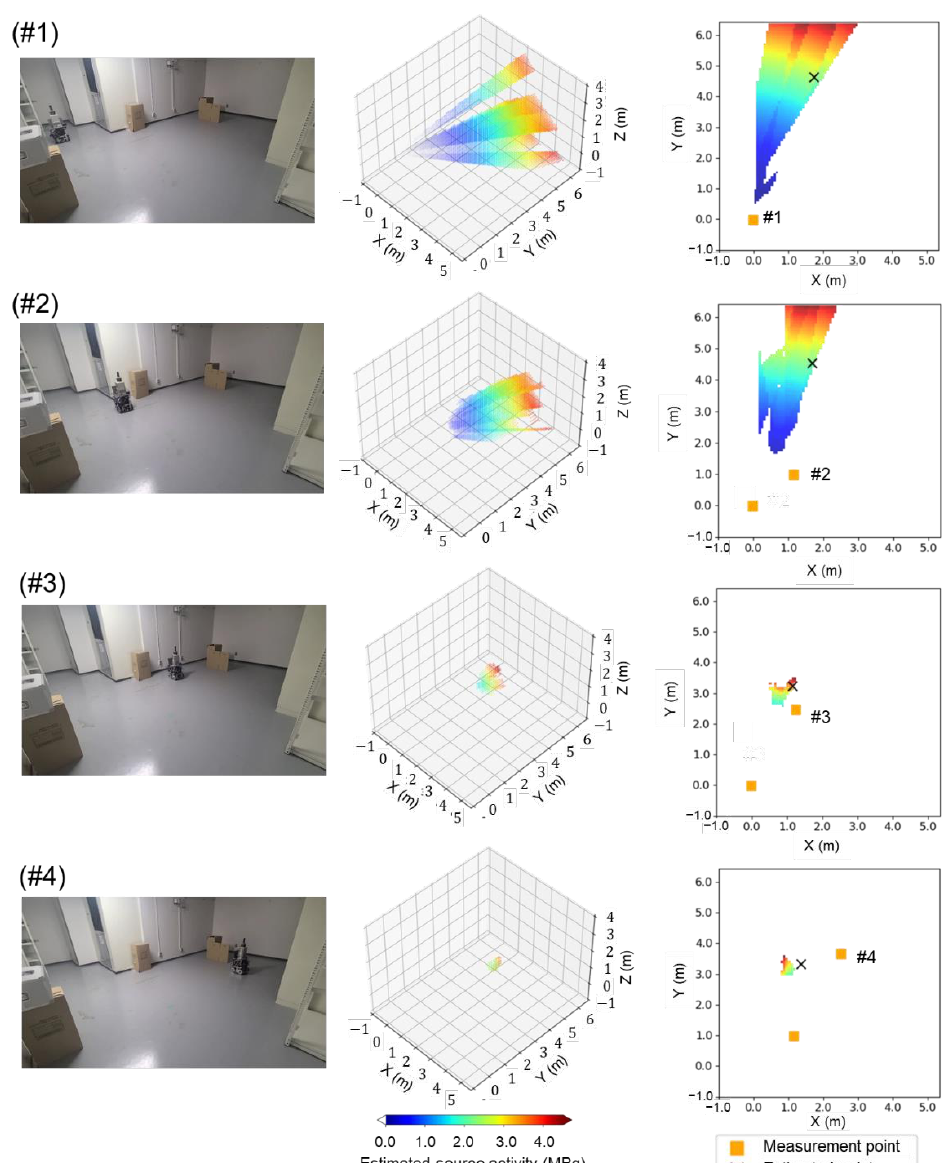
Figure 9. High-angle view of the search area ( left ), estimated source intensity and location in the 3D voxel area ( middle ), and estimation results in the xy plane at z = 0.2 ( right ) for each measurement position. Table 6. Summary of the source intensities and locations estimated in the experiment.